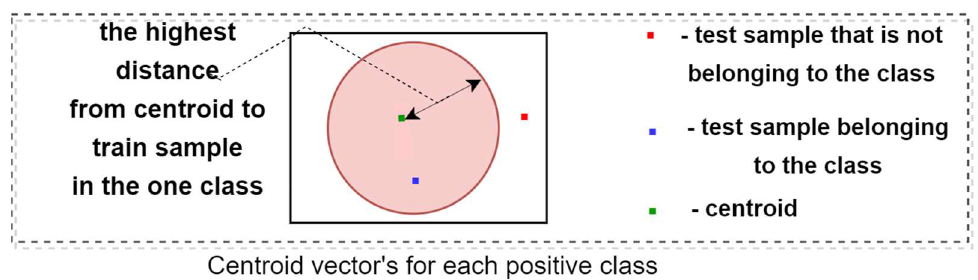
Figure 6. Illustration of the thresholding using Euclidean distance method.